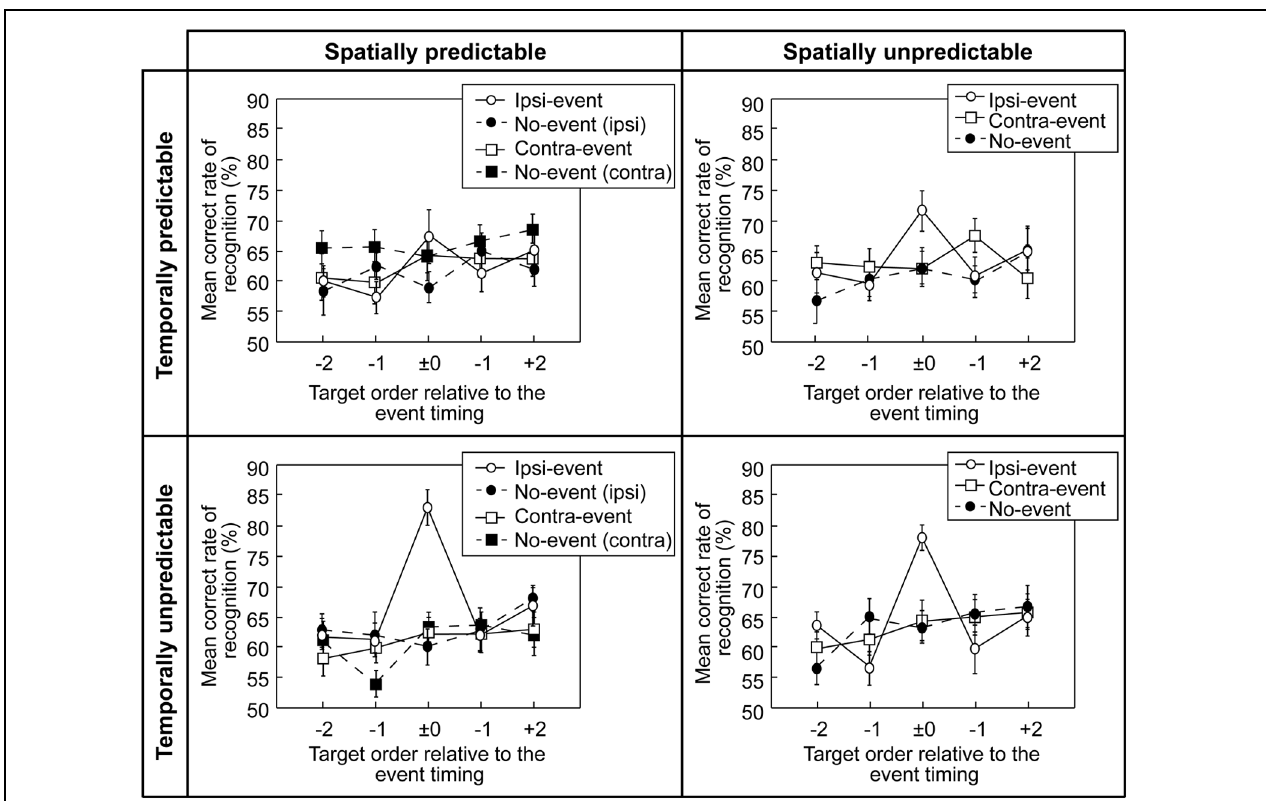
FIGURE 2 | Results of the working memory task in the four experiments. Mean correct percentages (averaged over the participants) of short-term recognition memory performance are shown as a function of temporal position of the target letter relative to the event timing (designated as zero on the abscissa). Error bars denote the standard errors of the means. For the no-event condition, zero on the abscissa reflects the time of the letter presentation in the middle of a letter sequence (i.e., from 1,620 ms to 1,890 ms). Since recognition memory accuracy was based upon a response to one of two letters, the chance level was 50%. No-event (ipsi) is the no-event data in the ipsi-lateral event block, No-event (contra) is the no-event data in the contra-lateral event